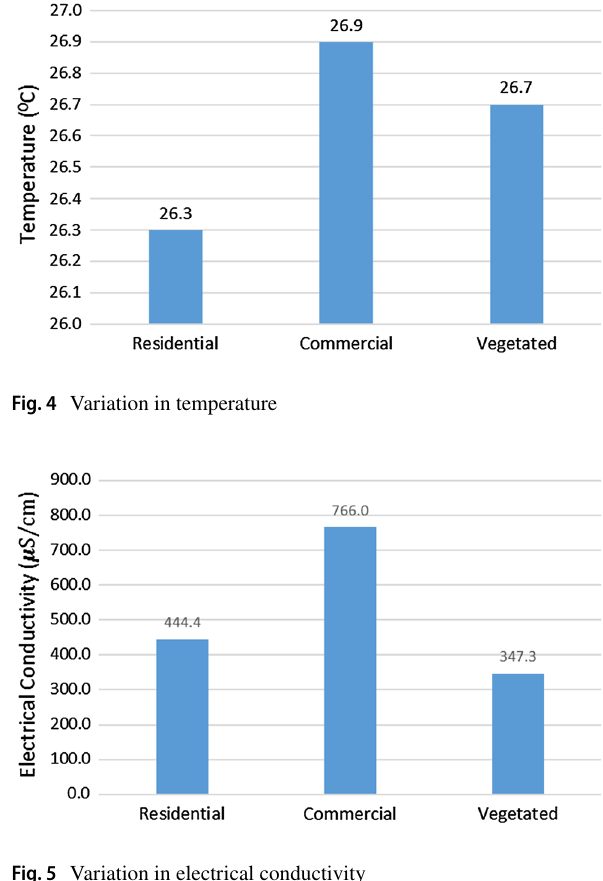
Fig. 5 Variation in electrical conductivity